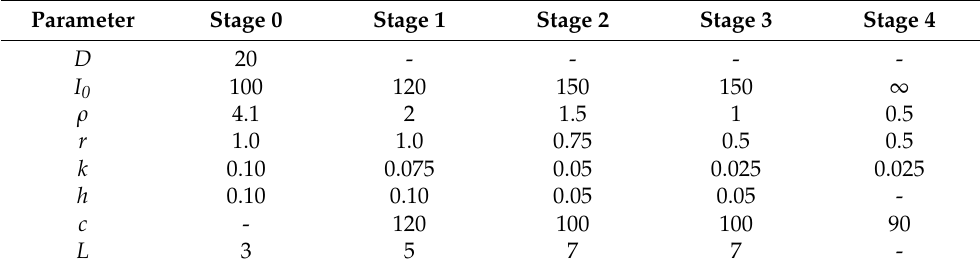
Table 3. Parameter values for the third numerical experiment. The first column contains model parameters. Stages from 0 to 4 correspond to different supply chain participants, from retail (stage 0) to a source of raw materials (stage 4).